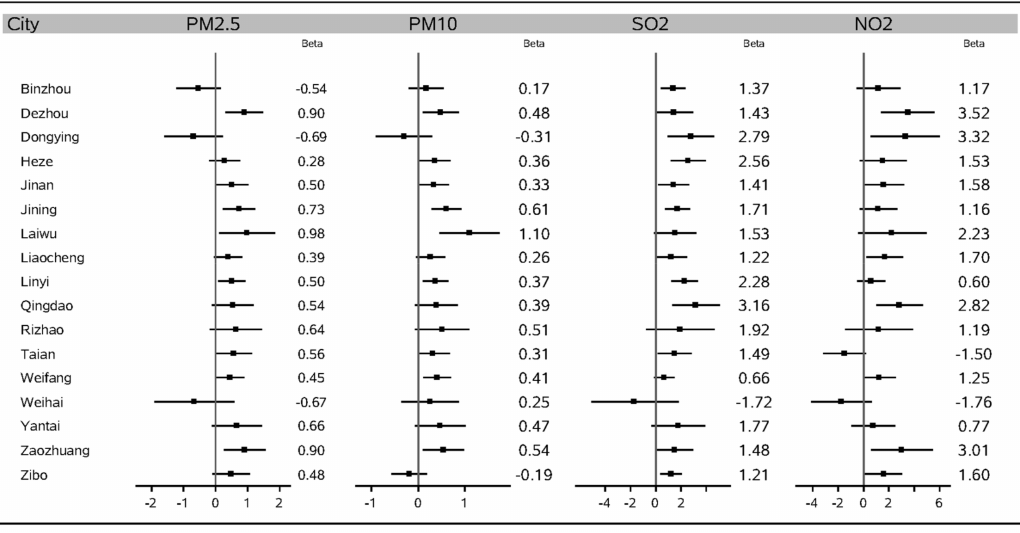
Figure 4. A forest plot of the percentage change in the relative risk of the total COPD hospitalizations with a 95% confidence interval (CI) per 10- µ g/m 3 increase in the air pollution levels in the 17 cities of the Shandong